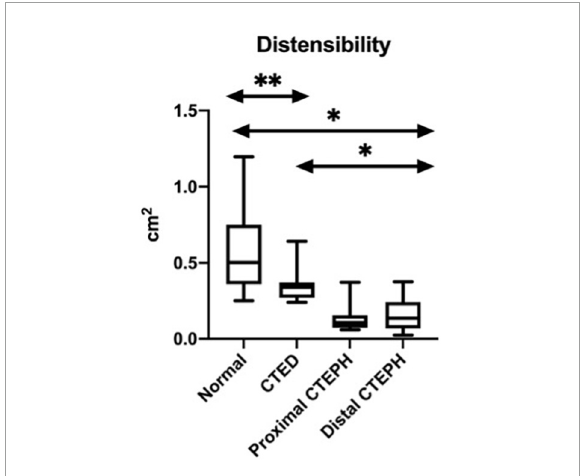
FIGURE5 Box and whisker plots for the variations in the novel CMR indices between thromboembolic disease subtypes. ∗ p < 0.01, ∗∗ p < 0.05.